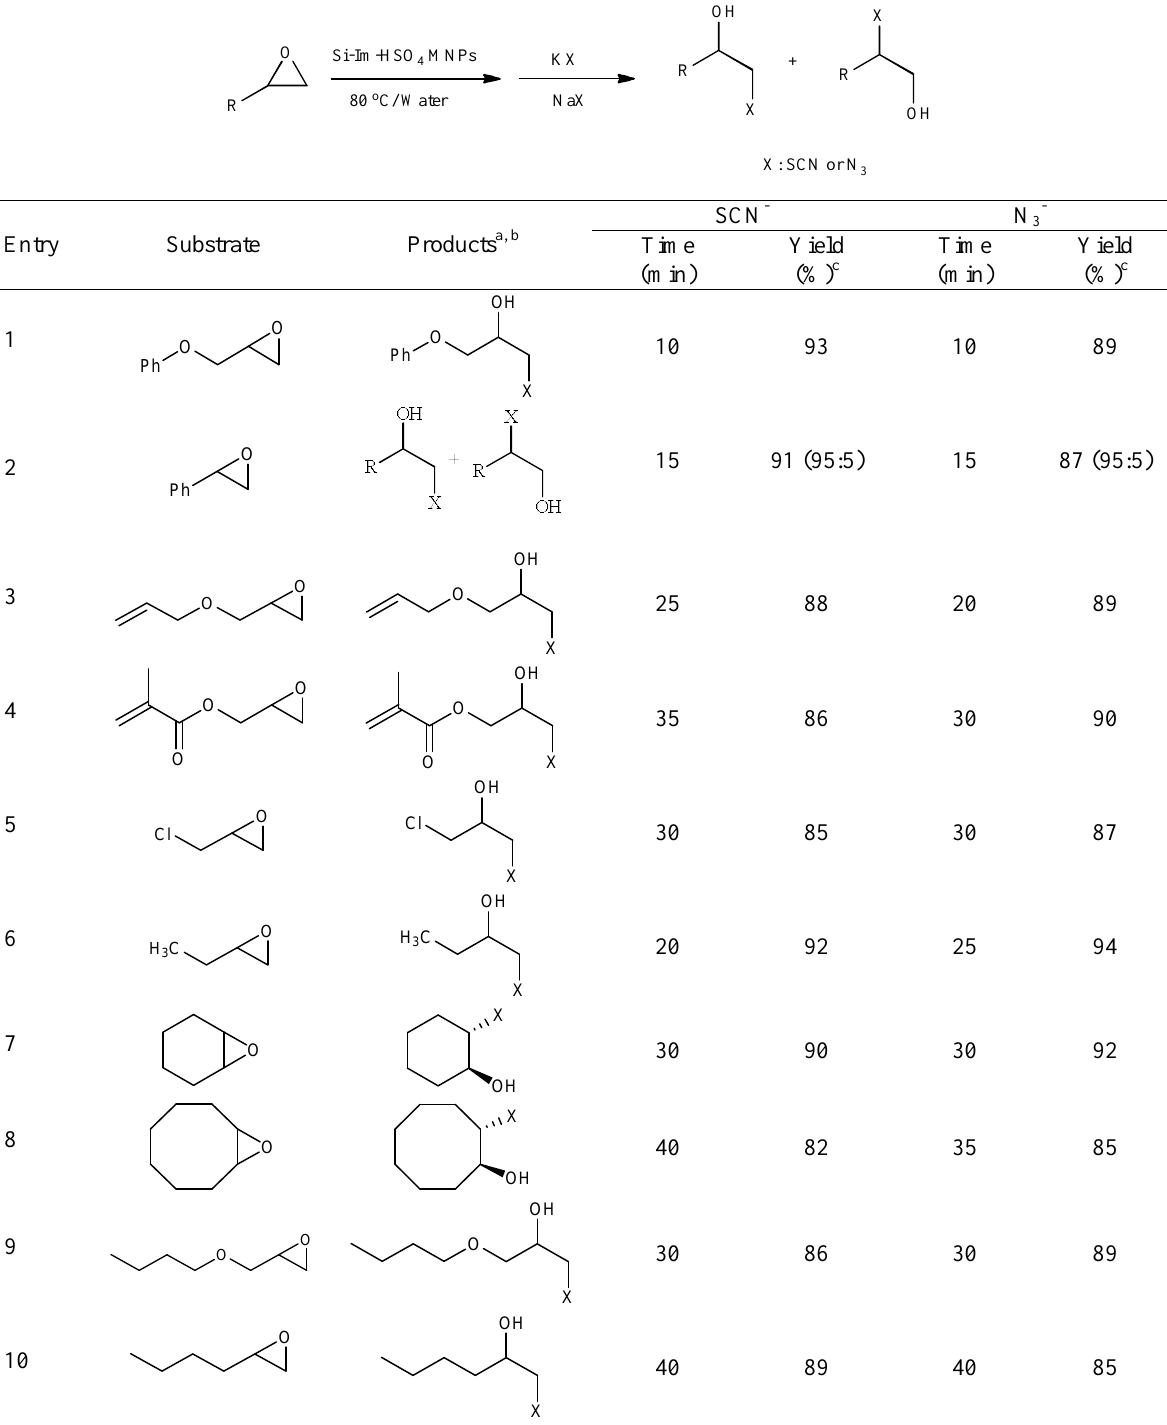
Table 2. Ring Opening of Various Epoxides in the Presence of Si-Im-HSO